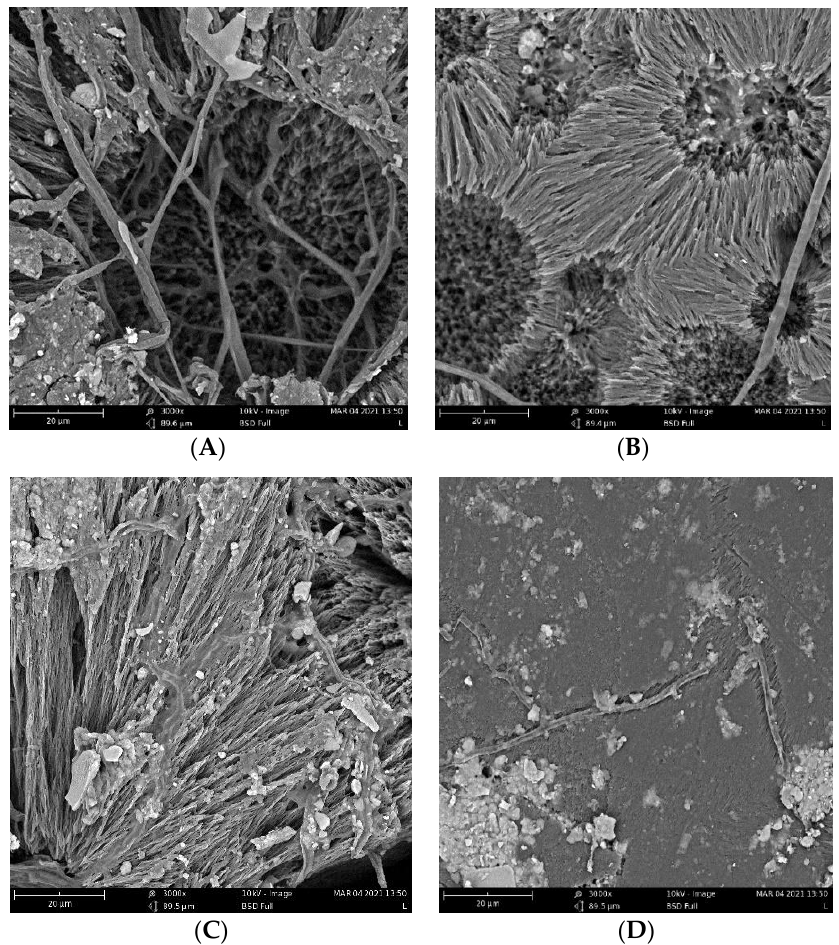
Figure 3. SEM images of the samples after 16 days of incubation: ( A ) pure PHB, ( B ) limonene 3%, ( C ) thymol 3%, and ( D ) eucalyptol 3%.